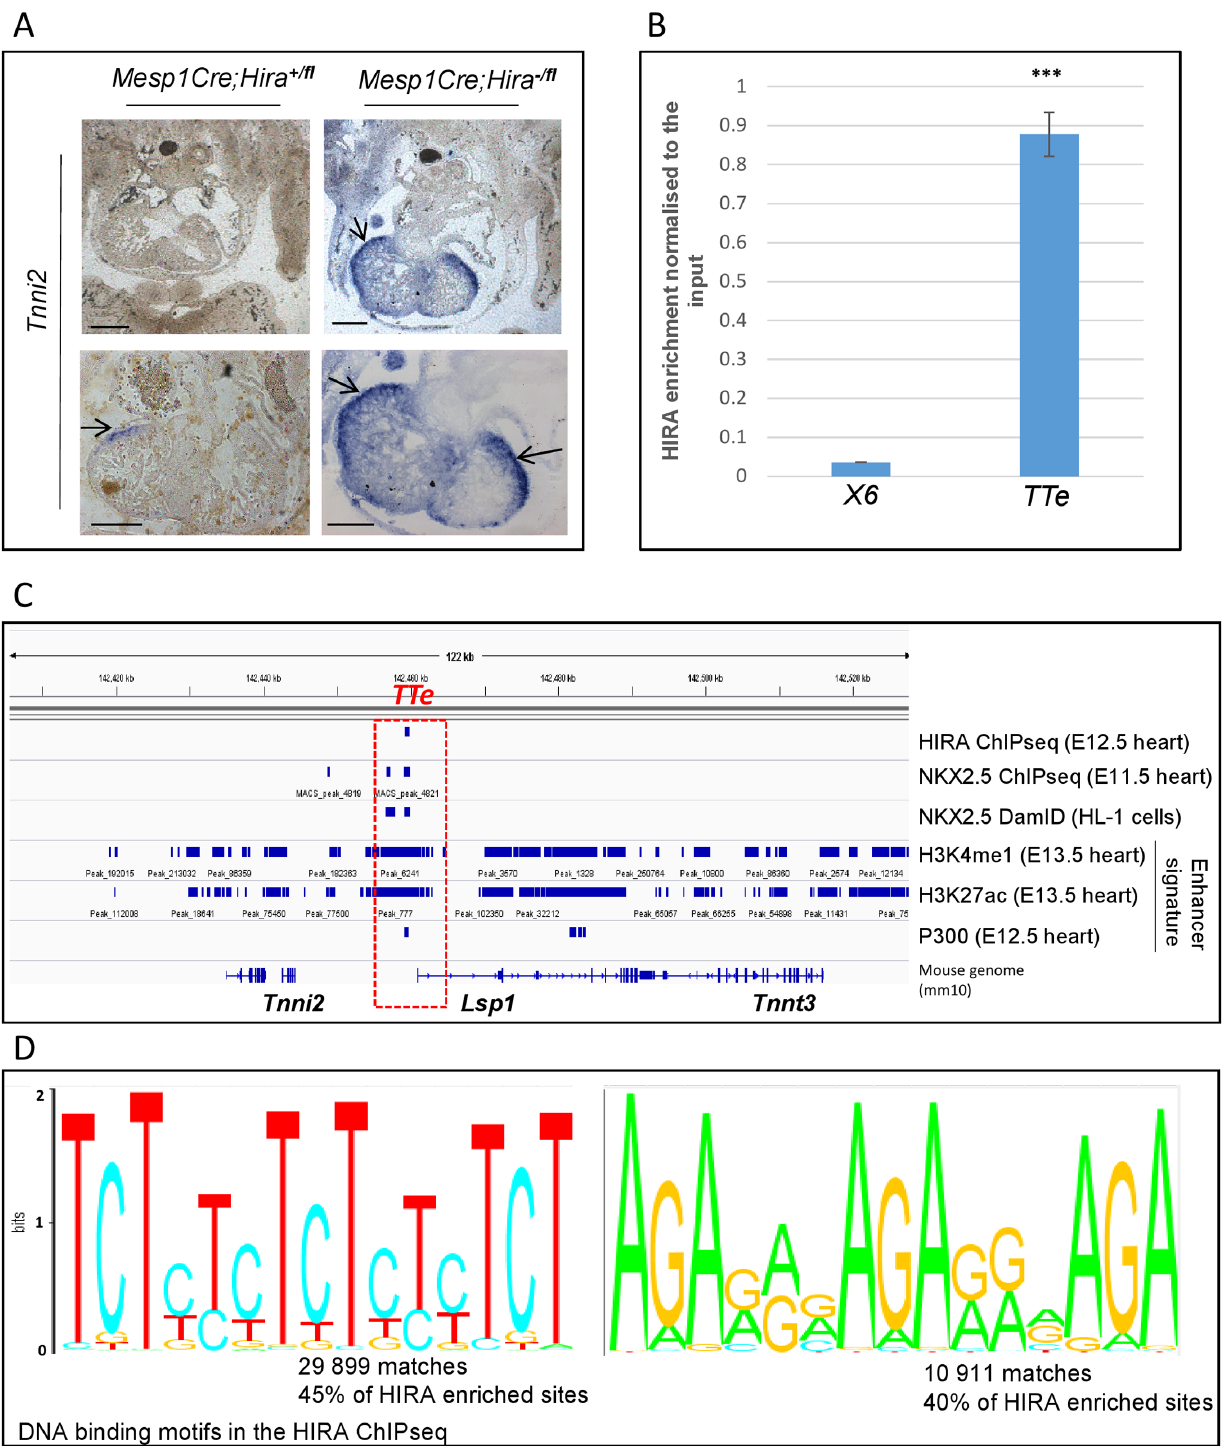
Fig 5. HIRA is enriched in the vicinity of Tnni2 / Tnnt3 , which is upregulated in conditionally deleted Hira mutants, and binds GAGA rich DNA. A. In situ hybridization Tnni2 on transverse sections of E12.5 embryos with the indicated genotype, revealed an abnormally increased expression of Tnni2 particularly in the ventricular free wall of the mutant hearts (arrows). Scale bar : 100 μ m B . qChIP of the HIRA enrichment at the TTe locus. An intergenic region on chromosome 6 was used as a negative control. Data is normalized to the input (= 100) and is representative of 2 independent experiments. Errors bars represent the min/max from technical duplicates. Unpaired t-test: p < 0.001 ***